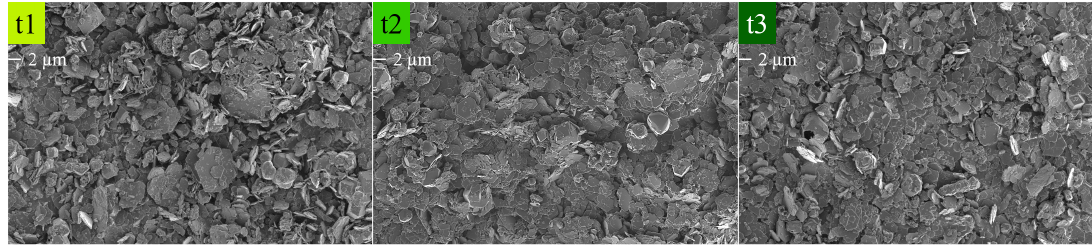
Figure 9. SEM micrographs of the time series of HC LDHs t1 = 1h, t2 = 3h and t3 = 6h at 1keV and 2k magnification. The scale bar is indicated under the label.